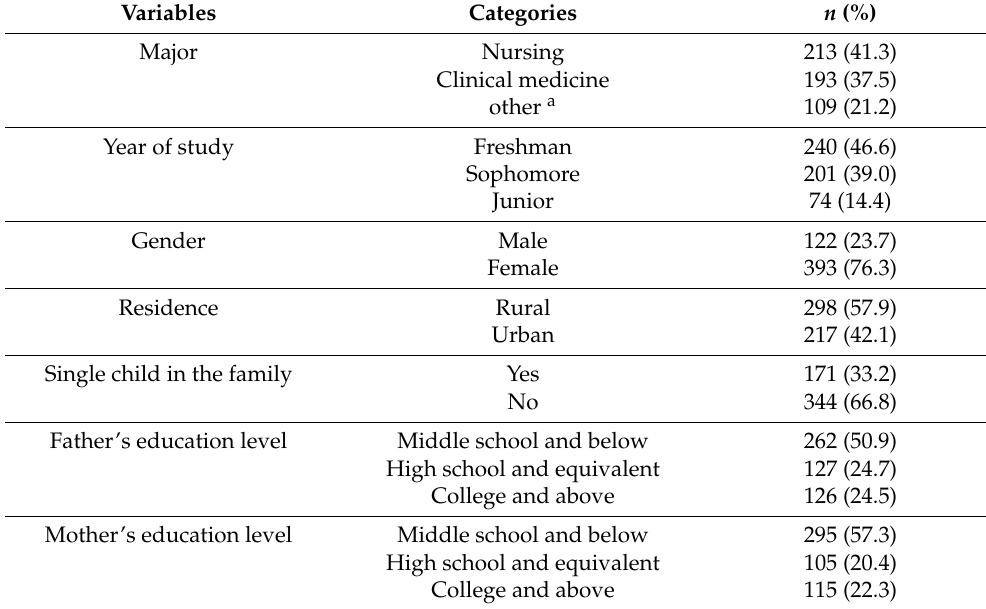
Table 1. Participants’ demographic characteristics (N =